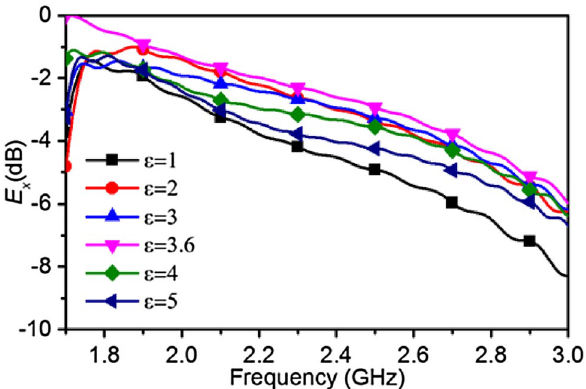
Figure 7. Normalized E x -field intensity at 50 mm inside human head versus dielectric filled waveguide permittivity variation from 1.7 to 3 GHz.